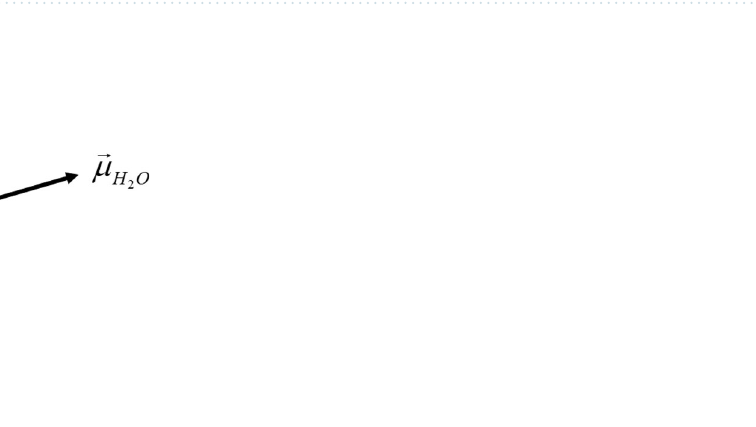
Figure 6. Definition of angles θ between the vectors of water dipole moment (cid:31) r µ H2O and the normal to the bilayers surface (cid:31) r